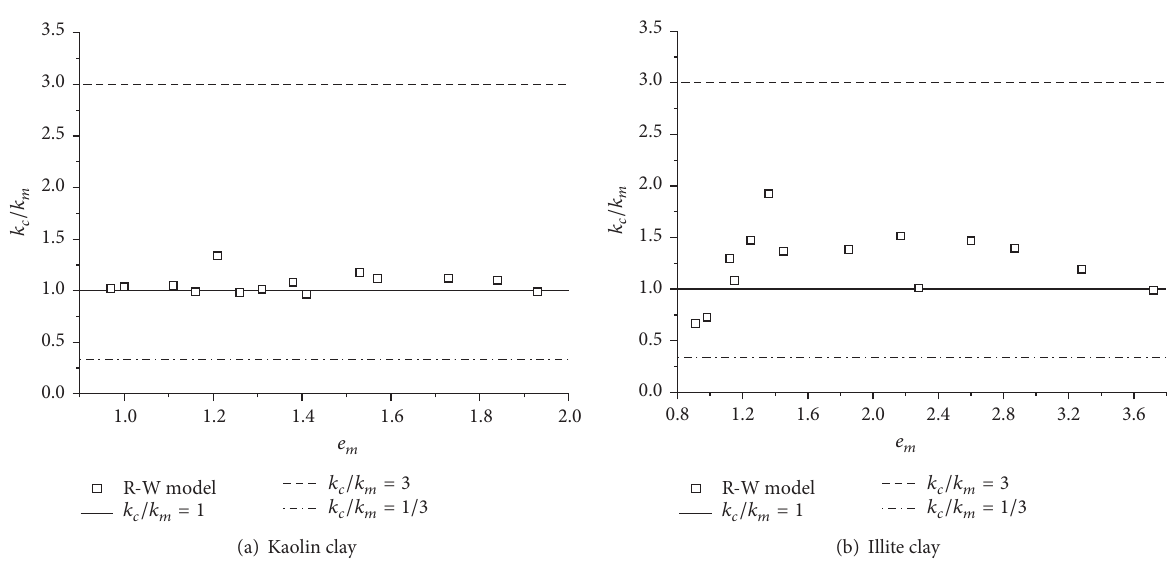
Figure 7: Comparison of the calculated and measured permeabilities using R-W